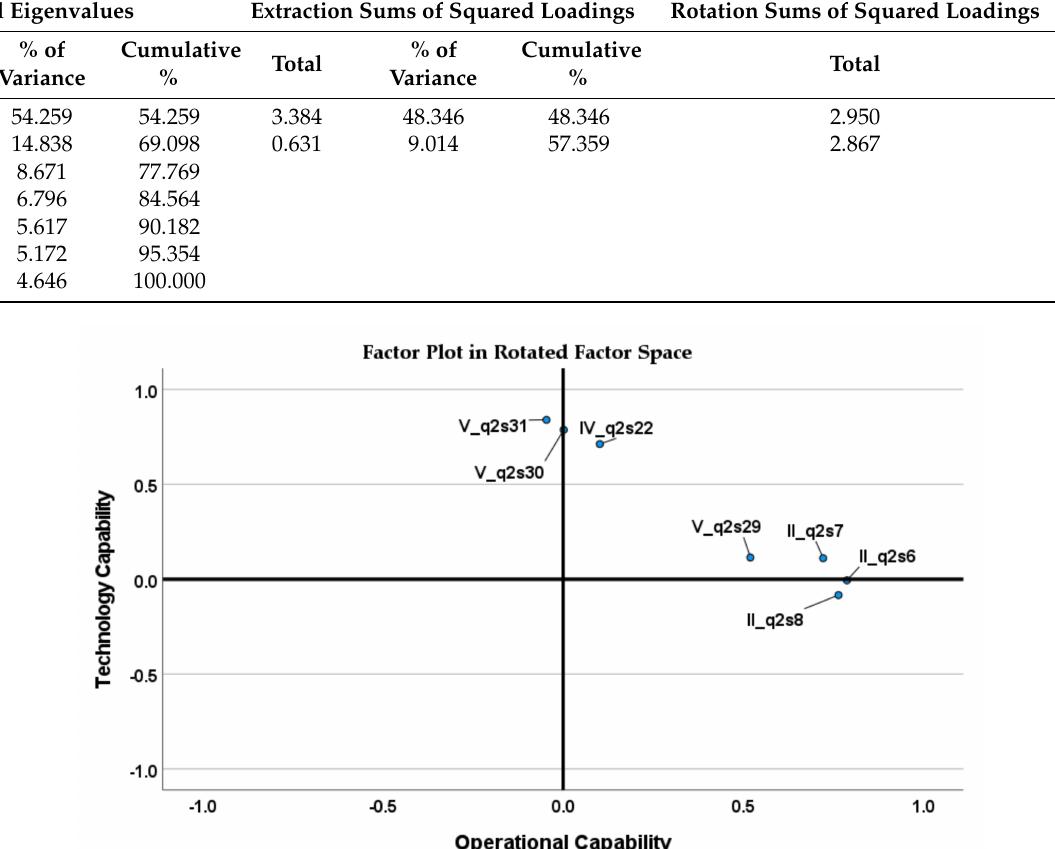
Table 9. Factor analysis results for variables IV-q2s22, V-q2s29, V-q2s30, V-q2s31, II-q2s6, II-q2s7, and II-q2s8. Extraction method: principal axis factoring.